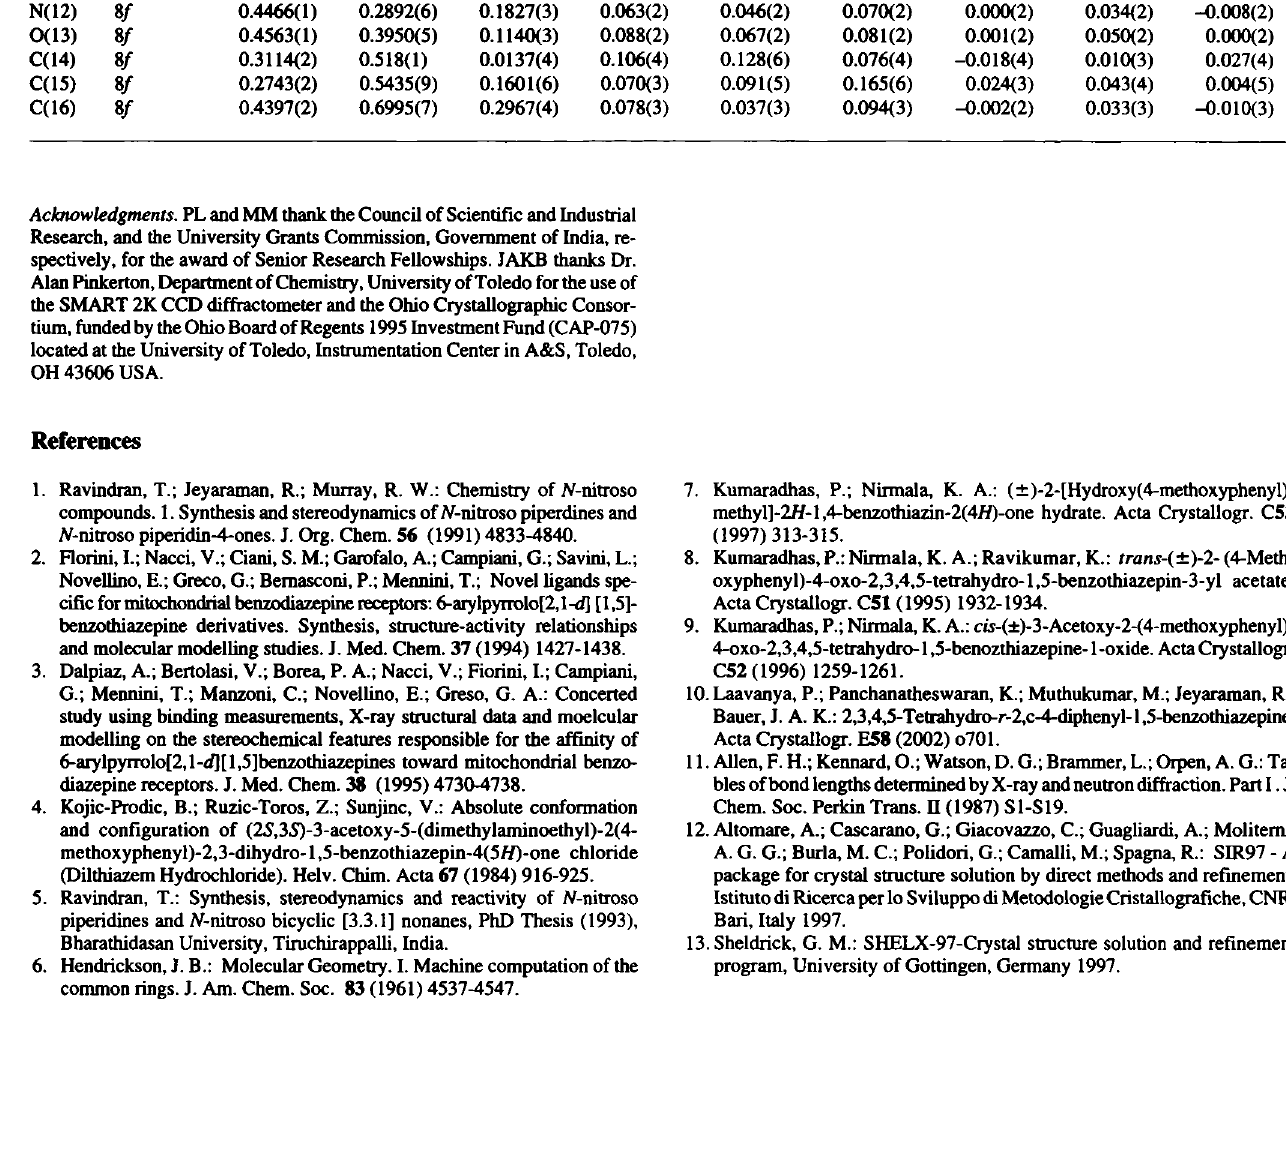
Table 3. Atomic coordinates and displacement parameters (in Â 2